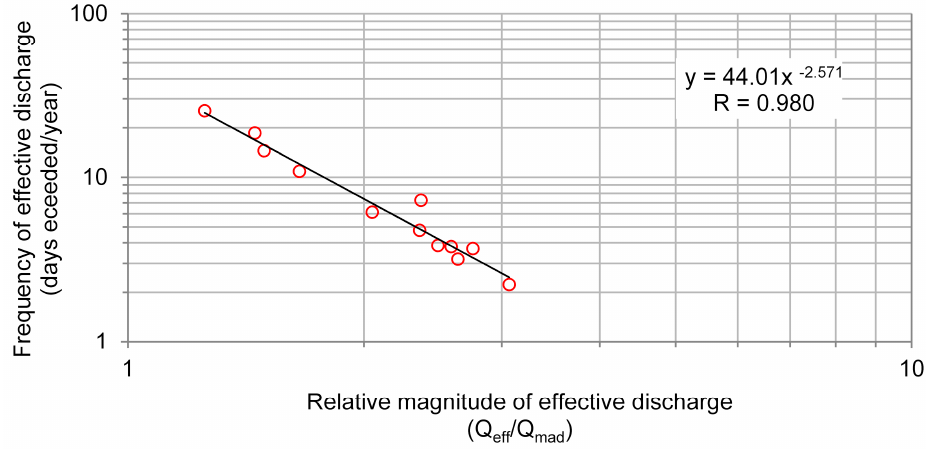
Figure 11. Relation between frequency of effective discharge and relative magnitude of effective